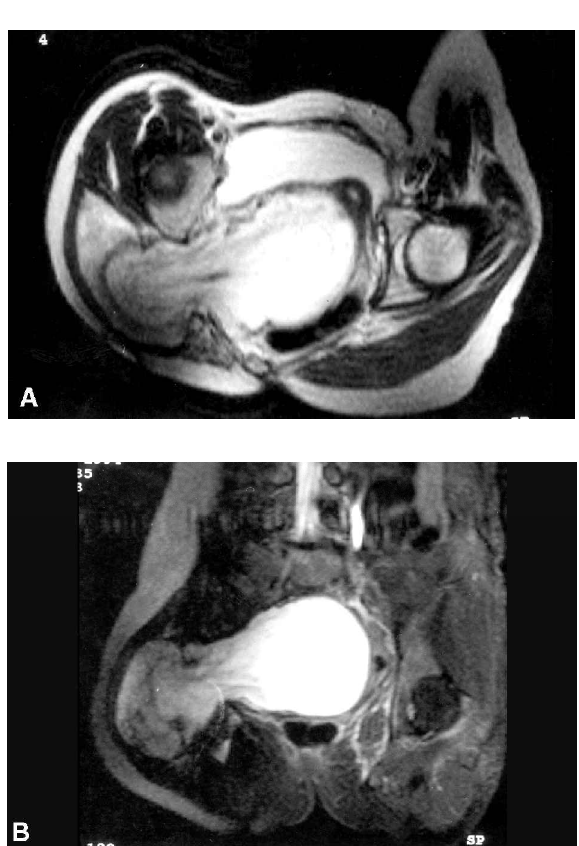
notch in transverse (a) and coronal (b)